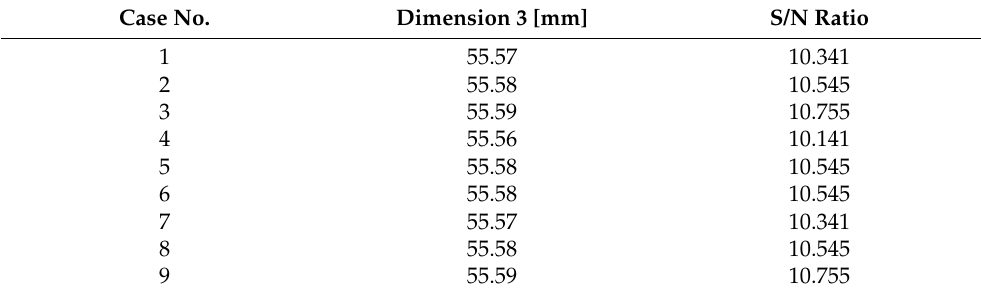
Table 15. S/N ratio of measurement 3 for pivot sub-assembly.